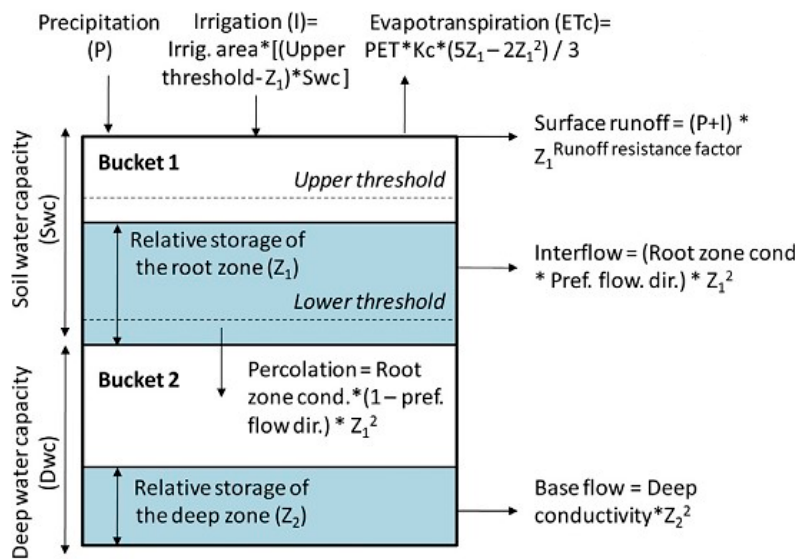
Figure 2. Conceptual diagram and equations incorporated in the soil moisture method [30].